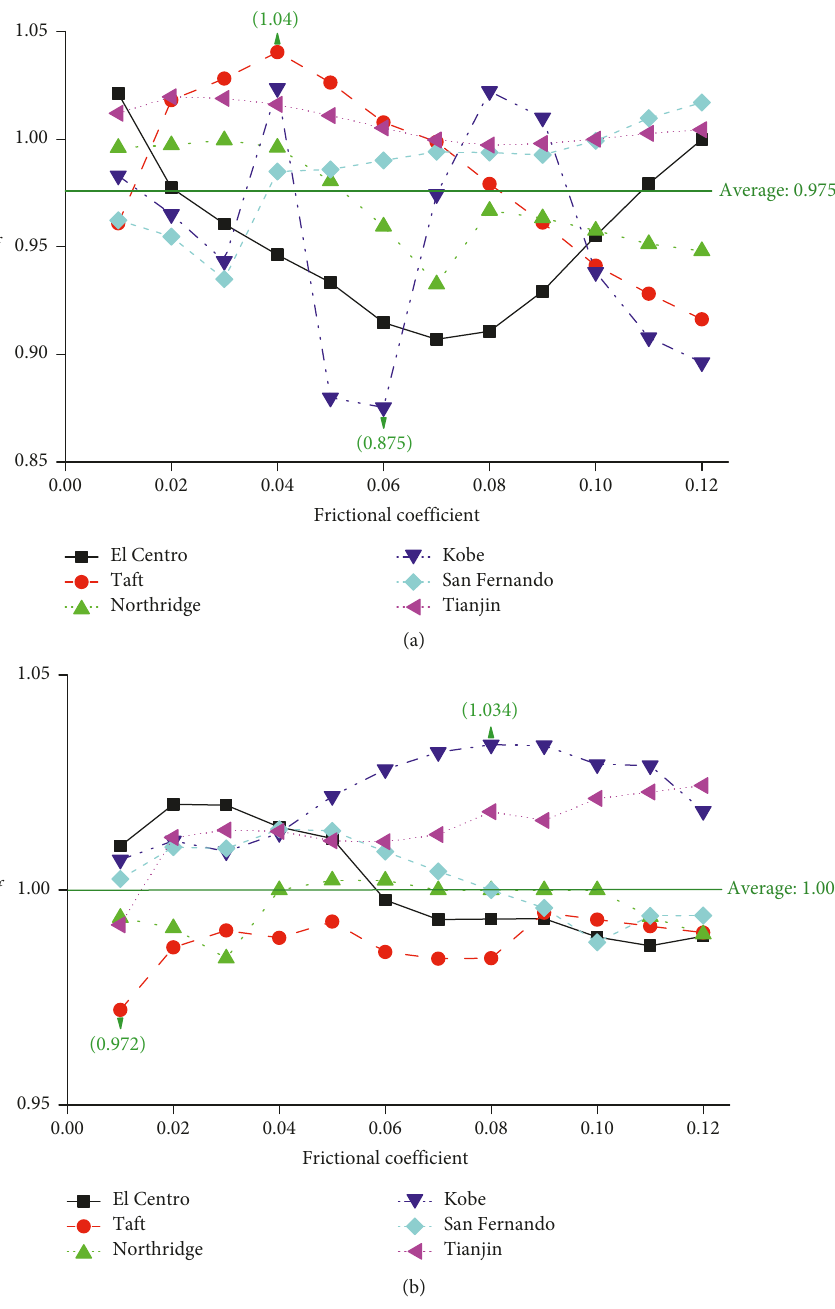
Figure 13: Comparison of the response amplitude of the main beam under various ground motions. (a) Displacement amplitude of the main beam. (b) Acceleration amplitude of the main